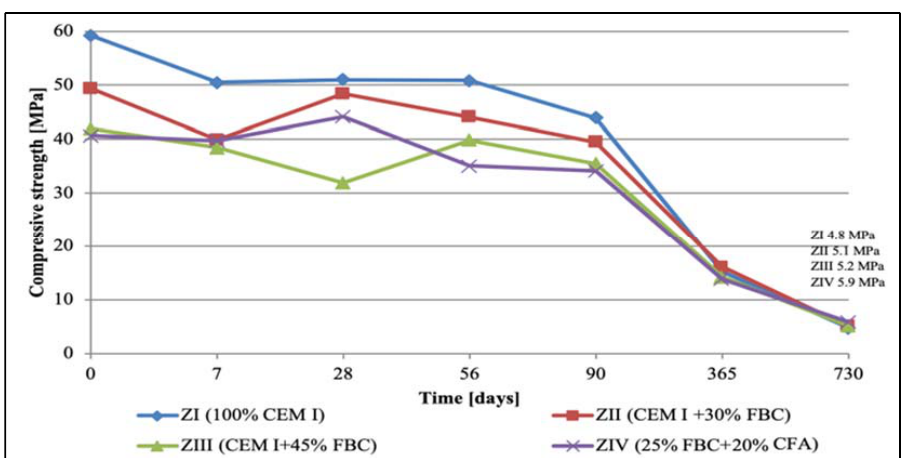
Figure 9. Compressive strength of mortars cured in 3% solution of hydrochloric acid with pH = 1.3 for 730 days.